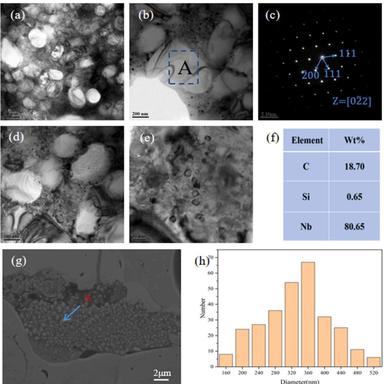
(a) NbC submicron grains, (b) high magnification of NbC submicron grains in (a), (c) SAED pattern of region A in (b) (calibrated as NbC phase), (d) high magnification of NbC submicron grains in (a), (e) high magnification of gap between NbC submicron grains, (f) EDS results of point A in (g), (g) SEM micrograph of NbC submicron grains, (h) particle size distribution of NbC submicron grains in (g).